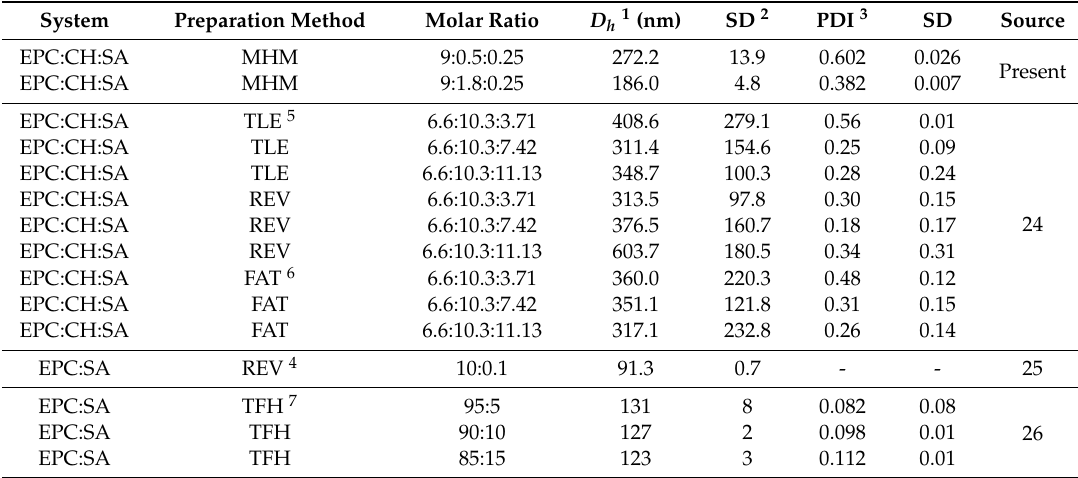
Table 4. The physicochemical properties of lipidic vehicles with incorporated curcumin developed through the MHM and other